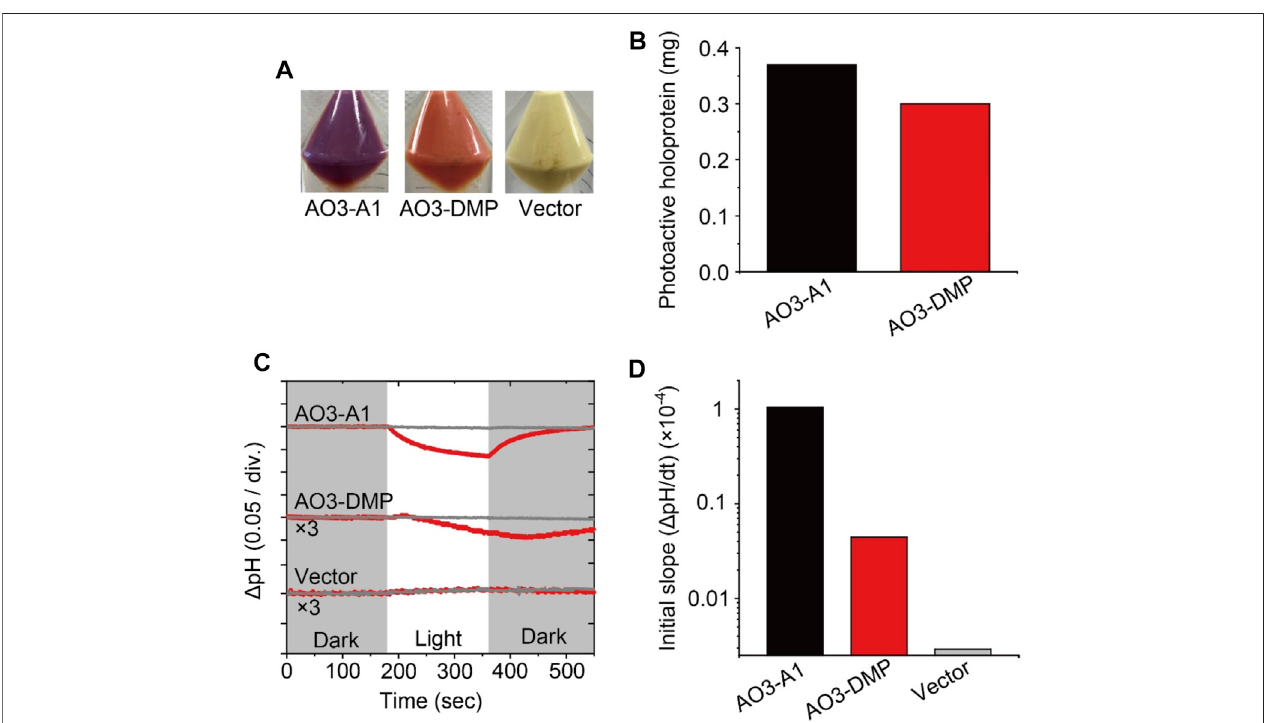
FIGURE 2 | Proton transport activity of AO3 with A1-retinal and DMP-retinal. (A) Photographs of E. coli cells harboring the expression plasmid for AO3 in the presenceofall- trans A1-retinal (AO3-A1,left) andDMP-retinal (AO3-DMP,middle) .Aphotographoftheplasmidvector (Vector,right) isshownasanegativecontrol. (B) Comparison of the total amounts of photoactive holoproteins in E. coli cells expressing AO3-A1 and AO3-DMP. (C) Light-induced pH changes of E. coli cells harboring expression plasmids of AO3 with A1-retinal (AO3-A1) and DMP-retinal (AO3-DMP) in the presence (gray lines) or absence (red lines) of the proton- selective ionophore, CCCP ( fi nal concentration of 4 μ M). The amplitudes of pH changes for AO3-DMP and the Vector were enlarged 3 times for comparison. The initial pH ranged from 6.1 to 6.3. The white background indicates the period of illumination. (D) The initial slope amplitudes of the light-induced pH changes, which were obtained from the data in panel